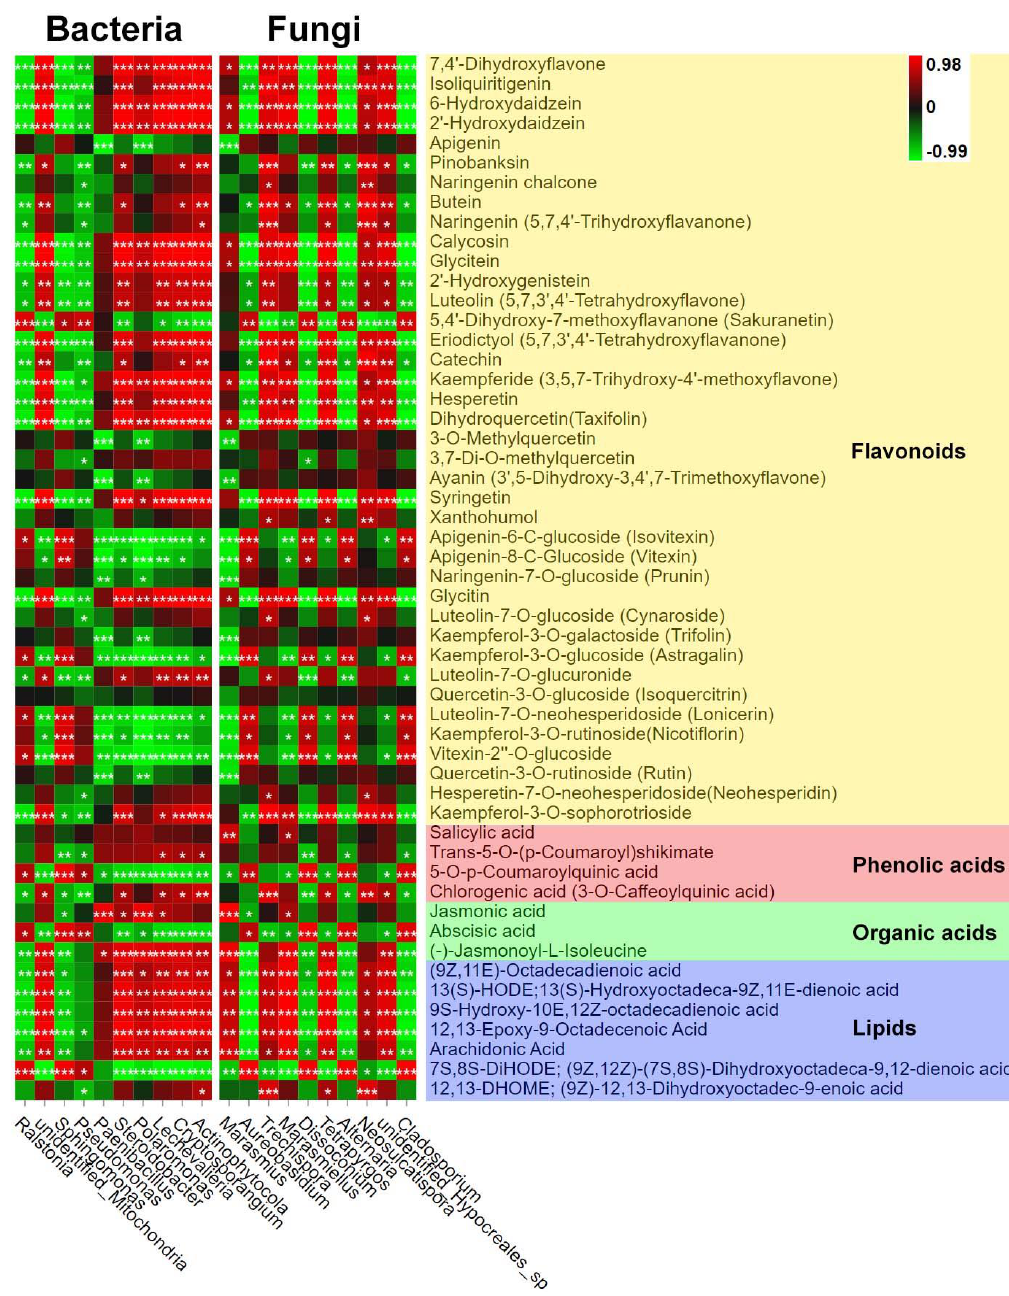
Figure 9. Pearson correlation of top 10 endophytes (bacteria and fungi) at the genus level with the significantly regulated metabolites of seven KEGG pathways. The abscissa represents the endophyte genera, and the ordinate represents the differential metabolites of the seven KEGG pathways. Red and green represent Pearson correlation (r); the key is shown at the top right corner. ‘*’, ‘**’, and ‘***’ indicate significant correlation at p ≤ 0.001, 0.001 < p < 0.01, and 0.01 < p < 0.05; p ≥ 0.05 (insignificant): not marked.